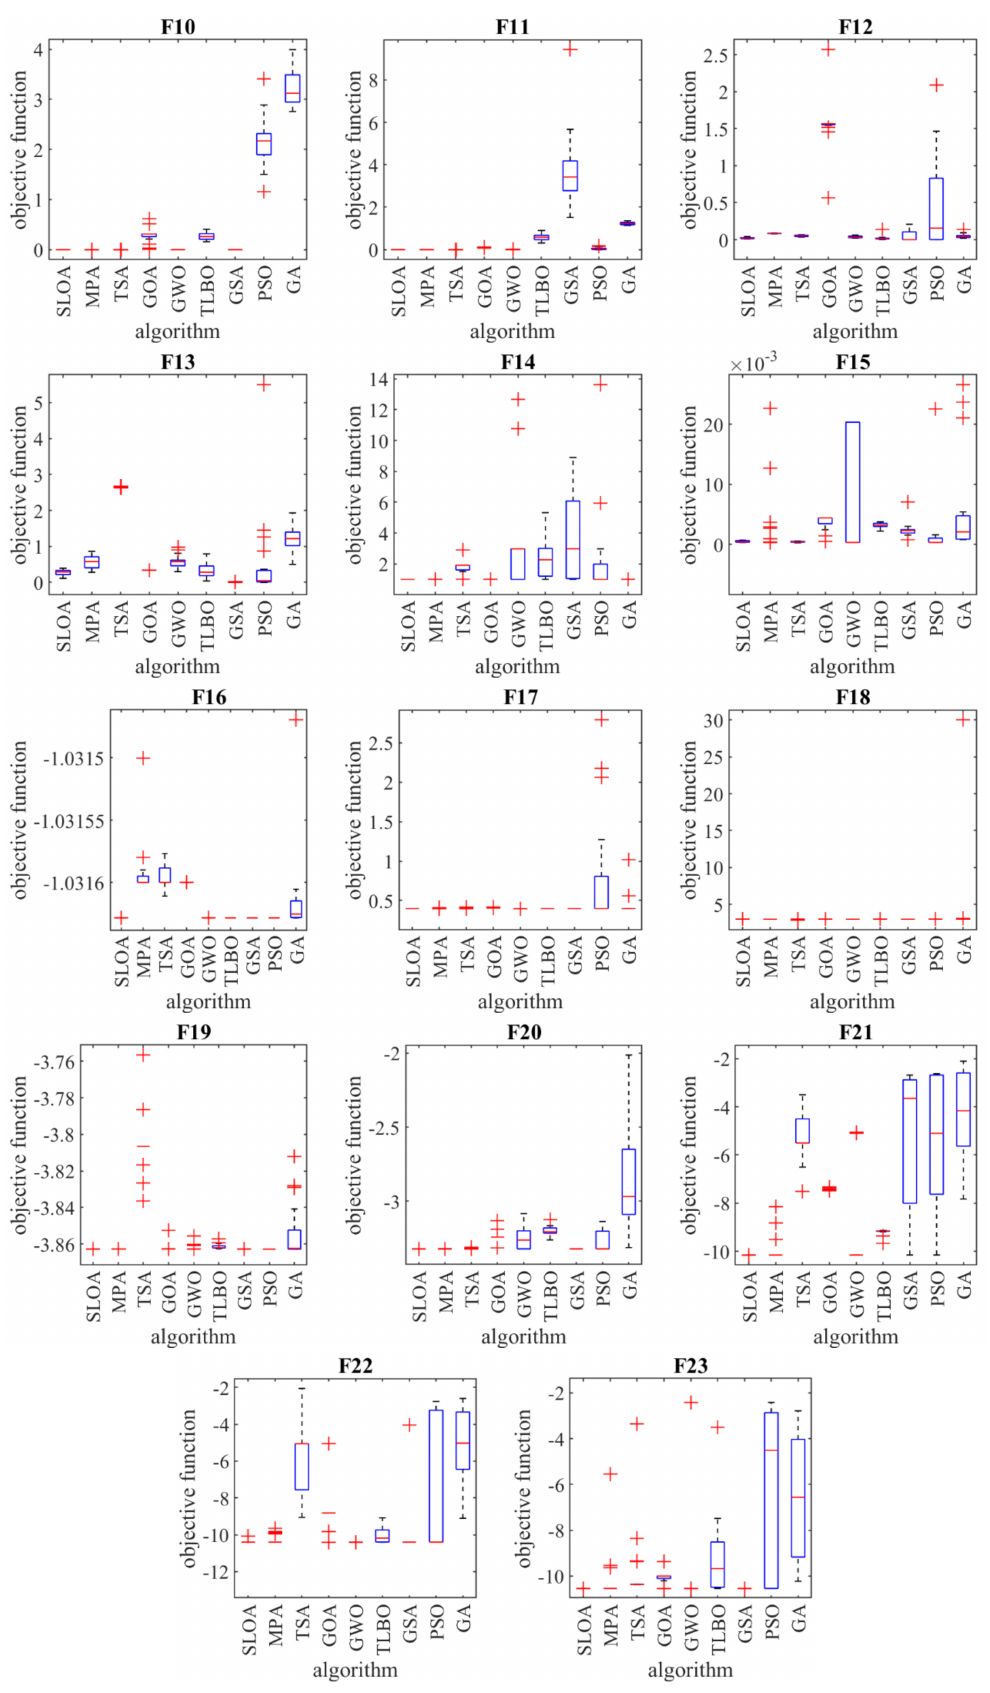
Figure 2. Boxplot of composition objective functions results for different optimization